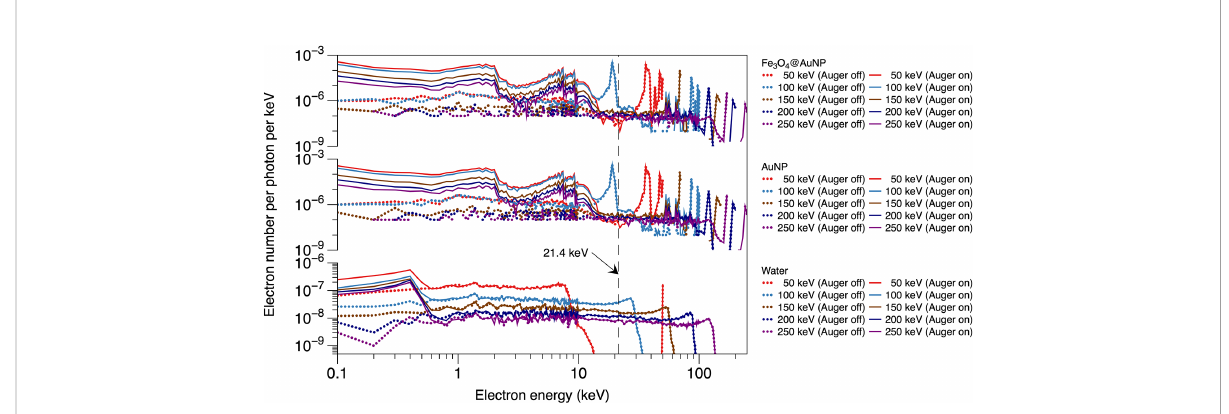
FIGURE 5 Electron energy spectra on the surface of Fe 3 O 4 @AuNP and AuNP for photon beams with various energy, with or without the Auger